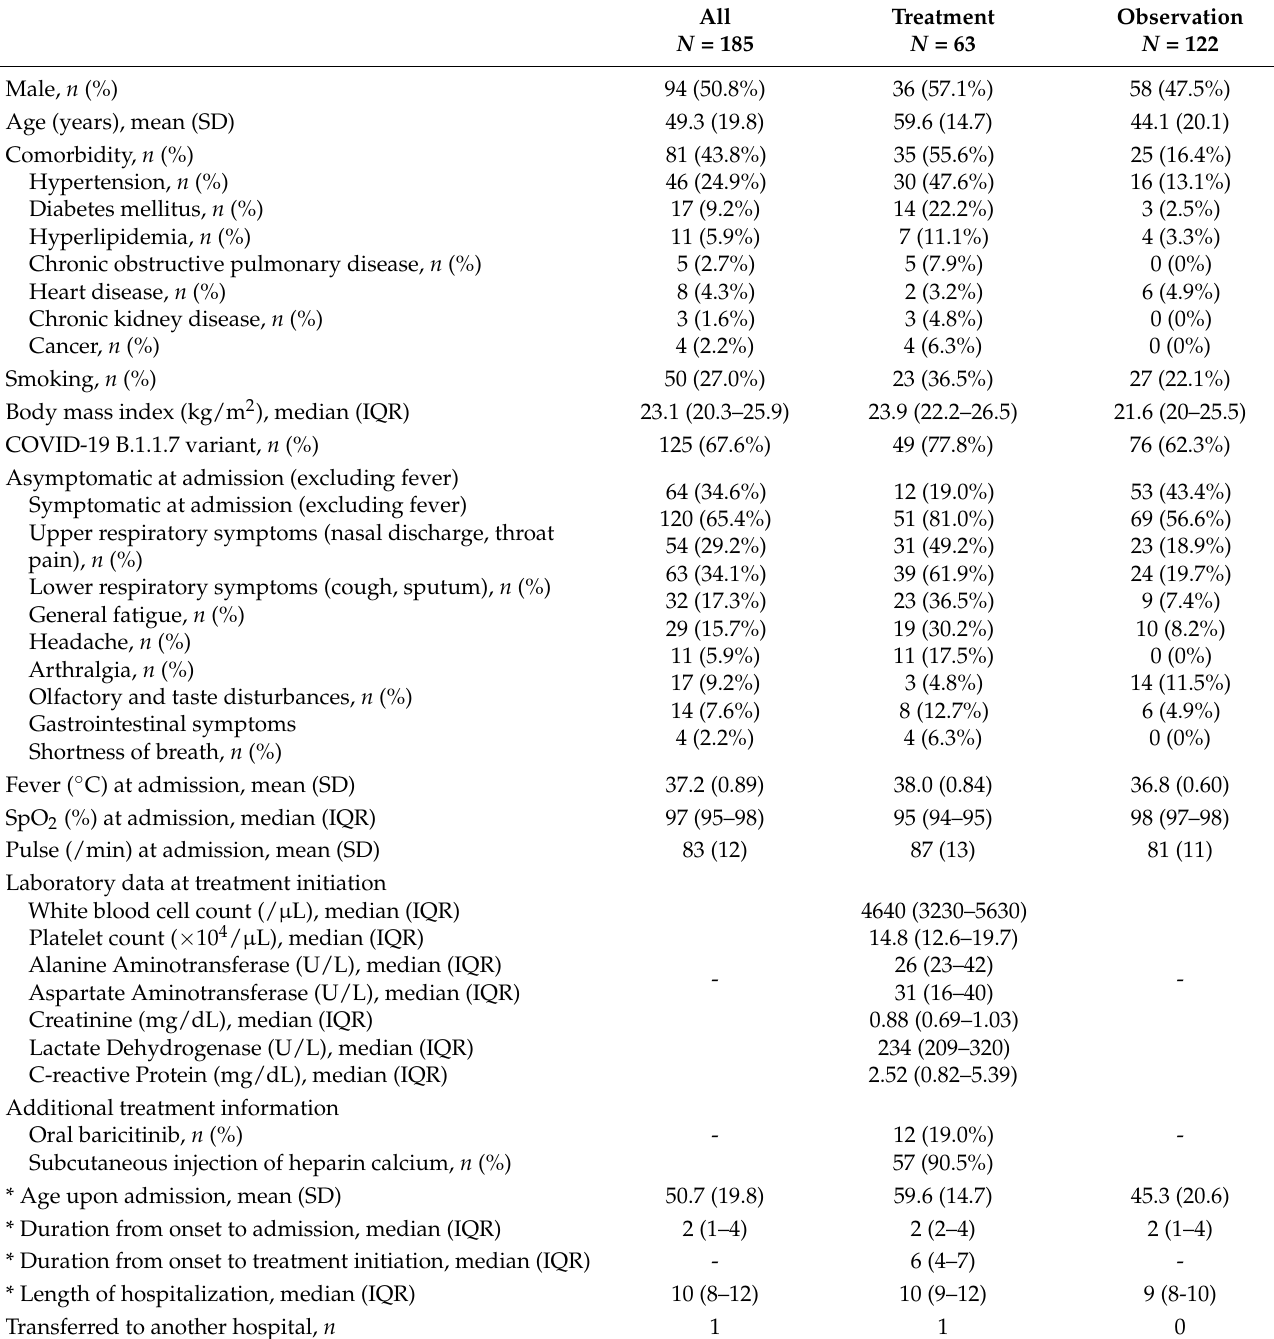
Table 1. Clinical characteristics and outcomes of COVID-19-infected patients in the fourth pandemic period according to treatment